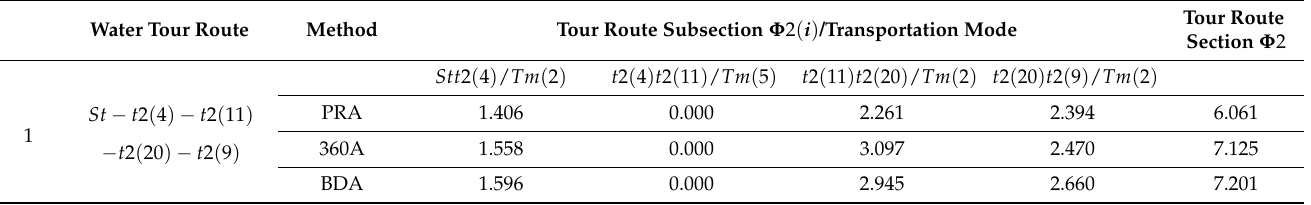
Table 7. The waste gas emission volumes for each scenic spot subsection and for the entire tour routes for the three methods under the same experimental conditions (unit: